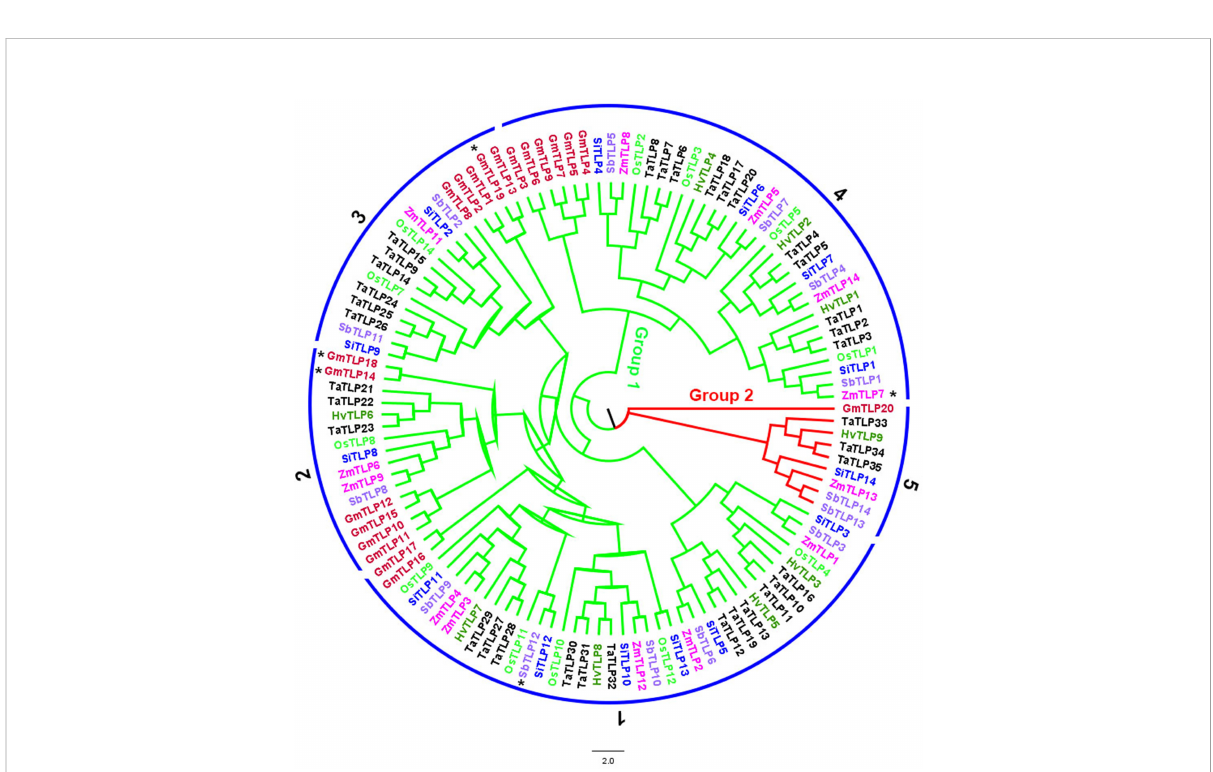
FIGURE 2 Thephylogeneticclassi fi cationofTLPproteinsfrom G.max , H.vulgare , S.bicolor , O.sativa , T.aestivum , S.italic and Z.mays .Differentcolorsrepresentdifferent crops.OrsweremarkedbynumbersandGmTLP14*,GmTLP18*,GmTLP19*ZmTLP7*andSbTLP12*werebelongedtoOr6,Or7,Or8,Or9,Or10.